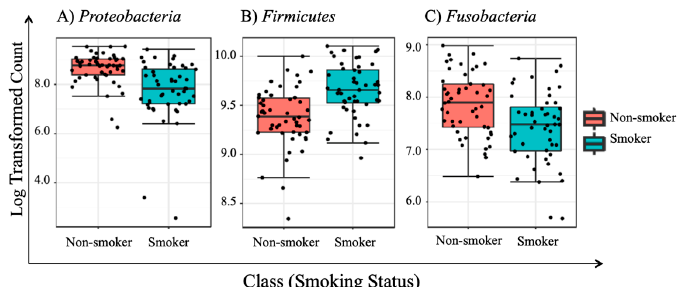
Figure 6. Boxplot for the three statistically impacted features identified by univariate analysis at the phylum level for non-smokers (red box) versus smokers (blue box) regardless of gender, statistically significant p -values with a significance level set at 0.05.